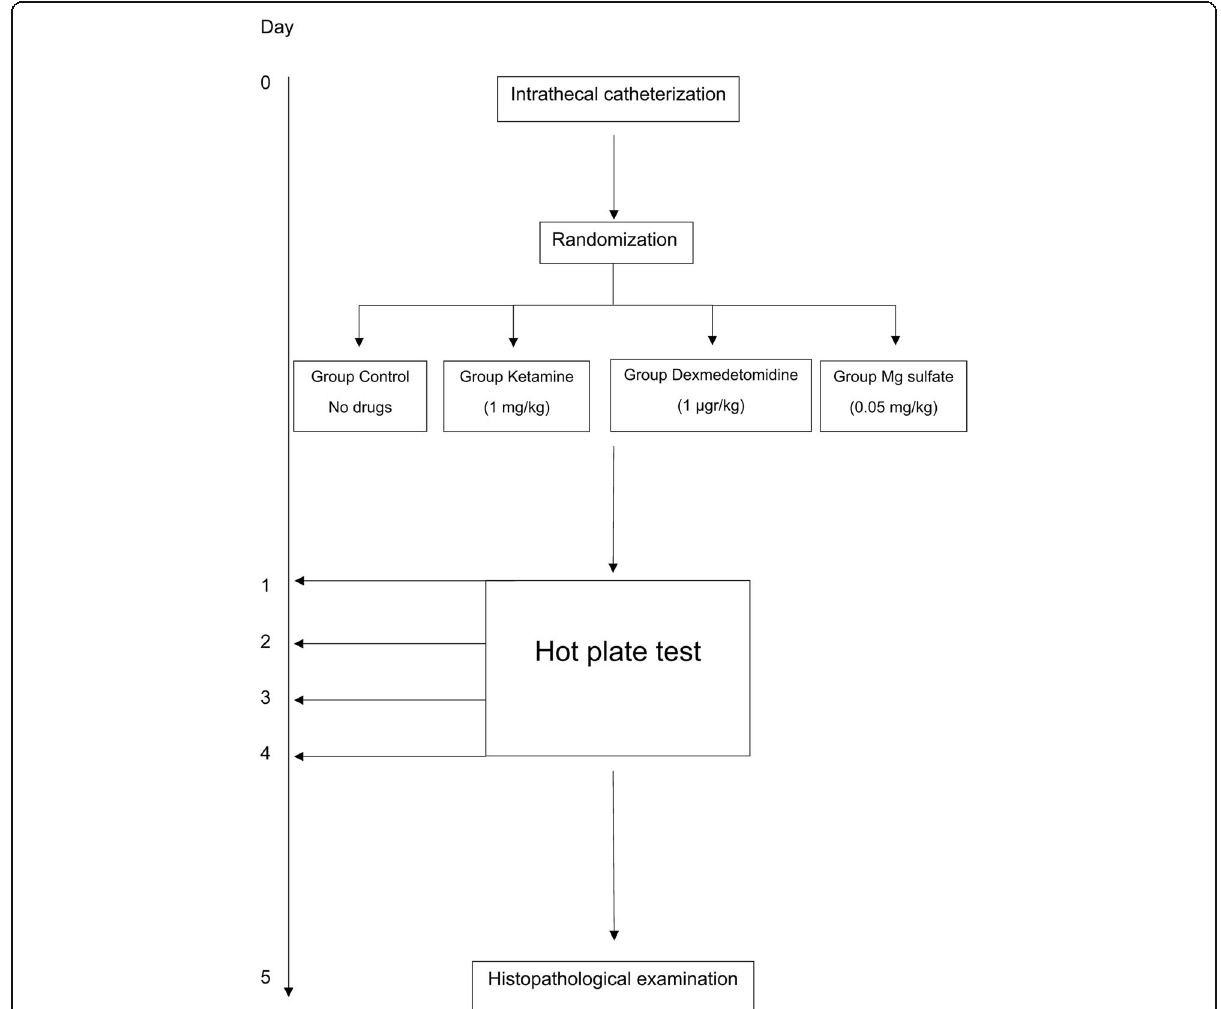
Fig. 1 The flowchart of the